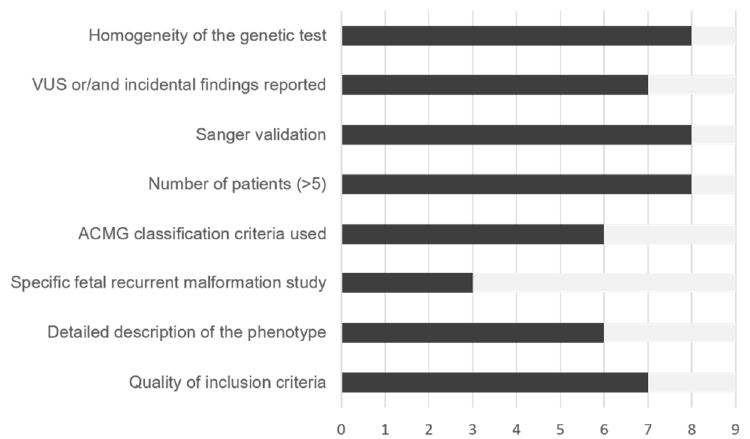
Figure 2. Quality assessment of the nine studies included in this systematic review using eight criteria. VUS: A variant of uncertain (or unknown) significance; ACMG: American College of Medical Genetics and Genomics. Table 1. Features of the nine studies included in this systematic review and meta-analysis.